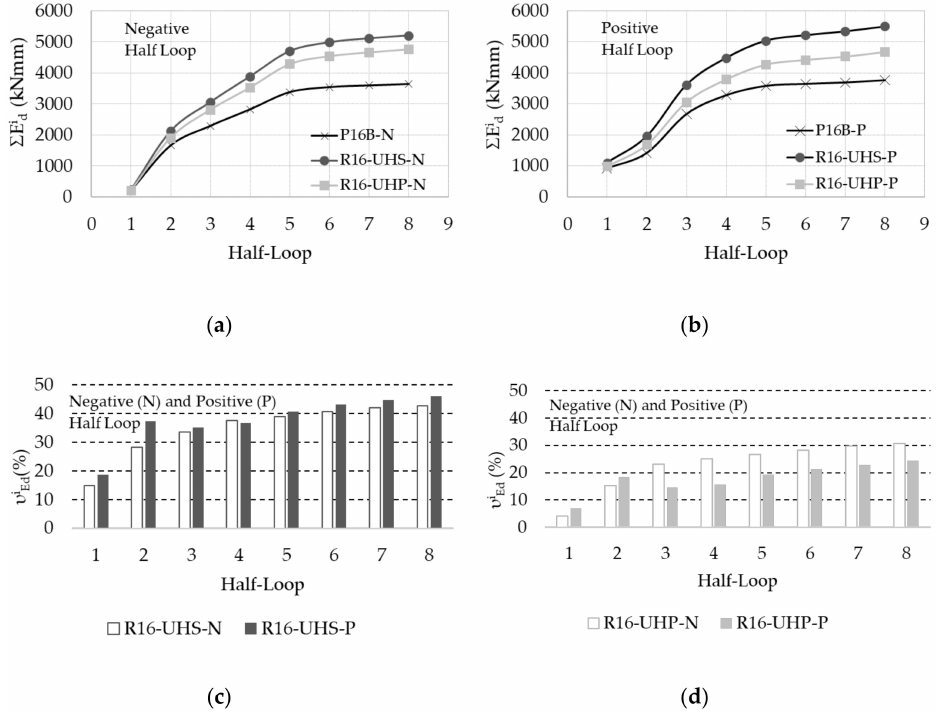
Figure 14. Cumulative dissipated energy ( Σ E i d ) calculated during the displacement history part Tol for the ASB column (P16B) and the repaired columns (R16-UHS, R16-UHP): ( a ) For the negative (N), and ( b ) for the positive (P) half loops. Dissipated energy variation ( υ i and ( d ) the column